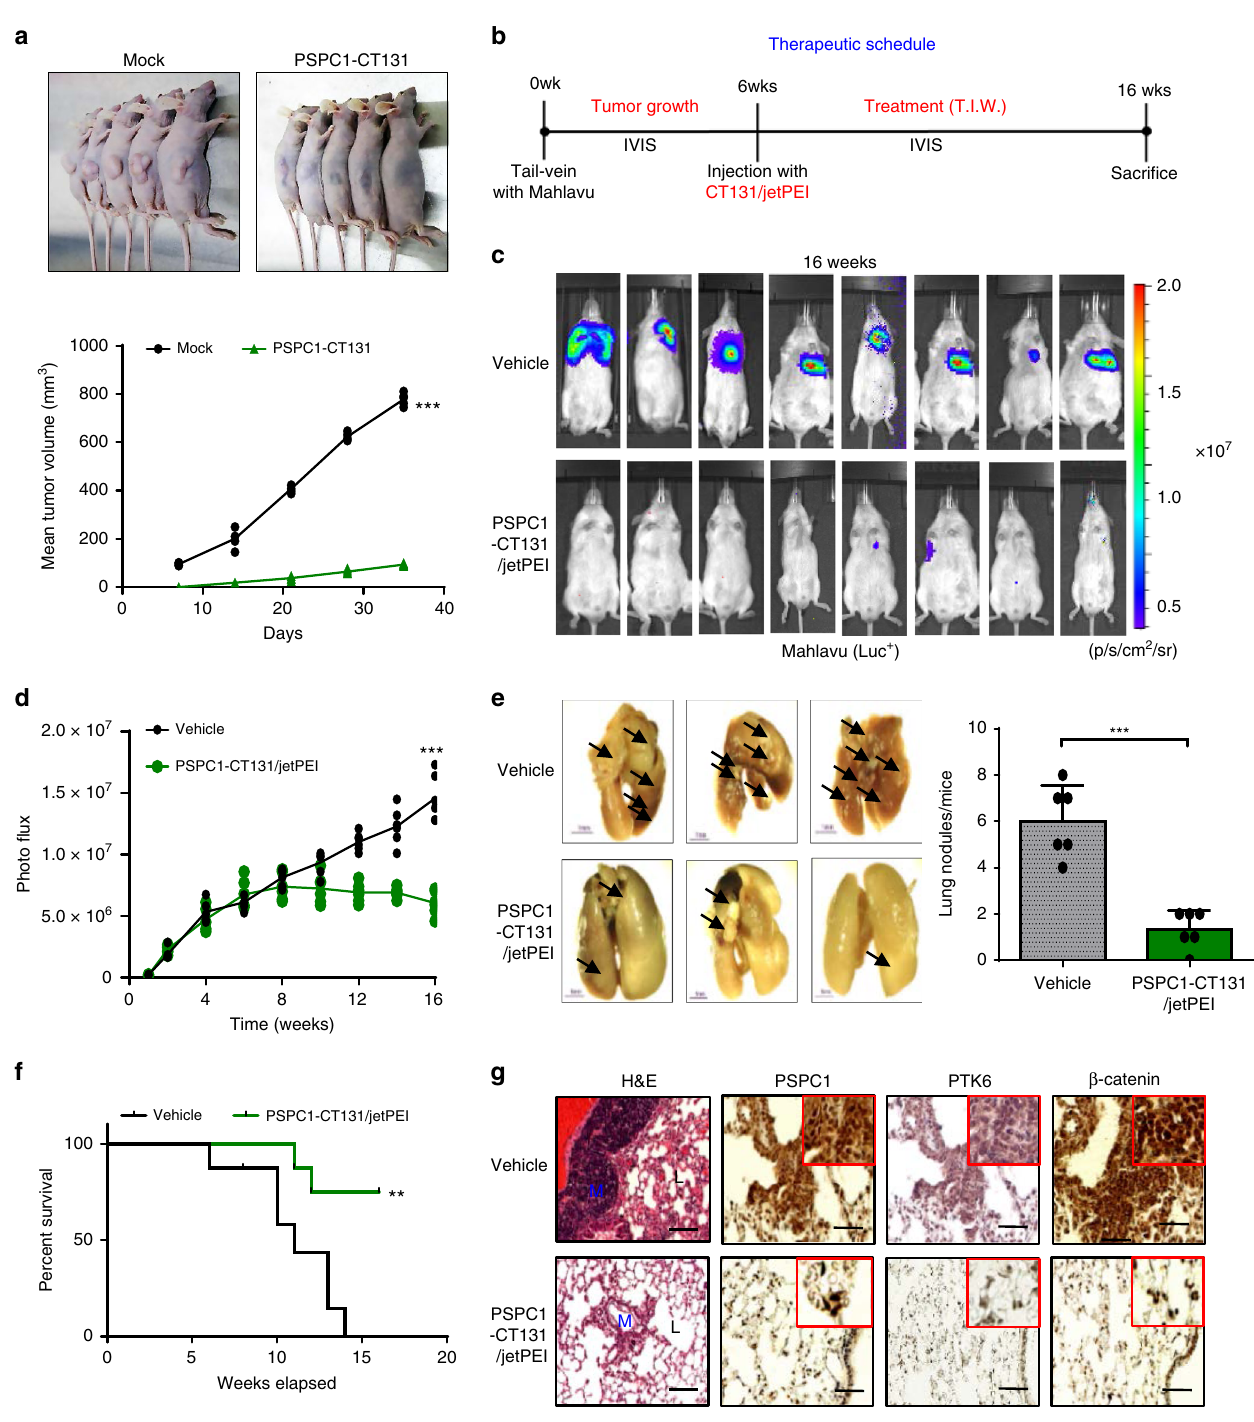
Fig. 7 PSPC1-CT131 targeting of PSPC1 and PTK6 reduces metastasis in HCC. a Representative images of nude mice (top) and the tumor growth curves (bottom) in nude mice injected with parental and PSPC1-CT131-overexpressing Mahlavu cells. Tumor volumes at 6 weeks post injection are presented as the mean ± SEM ( n = 5/group). Data statistics were based on * p < 0.05, ** p < 0.01, and *** p < 0.001 calculated by ordinary two-way ANOVA with post hoc Tukey ’ s test compared to the mock control. b Time fl owchart of the therapeutic schedule of tail vein injections of PSPC1-CT131/jetPEI ® into mice carrying tail vein injected Mahlavu cells. c Representative bioluminescence images of experiments in ( b ). d – f Injection of PSPC1-CT131 plasmid packaged in vivo with jetPEI ® not only reduced lung metastasis ( d , e ) but also prolonged mouse survival ( f ) in the tail vein injected lung metastasis model ( n = 8/groups). Data statistics were based on * p < 0.05, ** p < 0.01, and *** p < 0.001 calculated by Log-rank test compared to vehicle control. g Validated expressions of the PSPC1/PTK6/ β -catenin axis by IHC staining of lung tumors after the administration of PSPC1-CT131 in a mouse lung metastasis model. Red squares on the top right corner of each IHC image stand for enlargement of stained tissues. The scale bar represents 100 µ m. Source data are provided as a Source Data fi